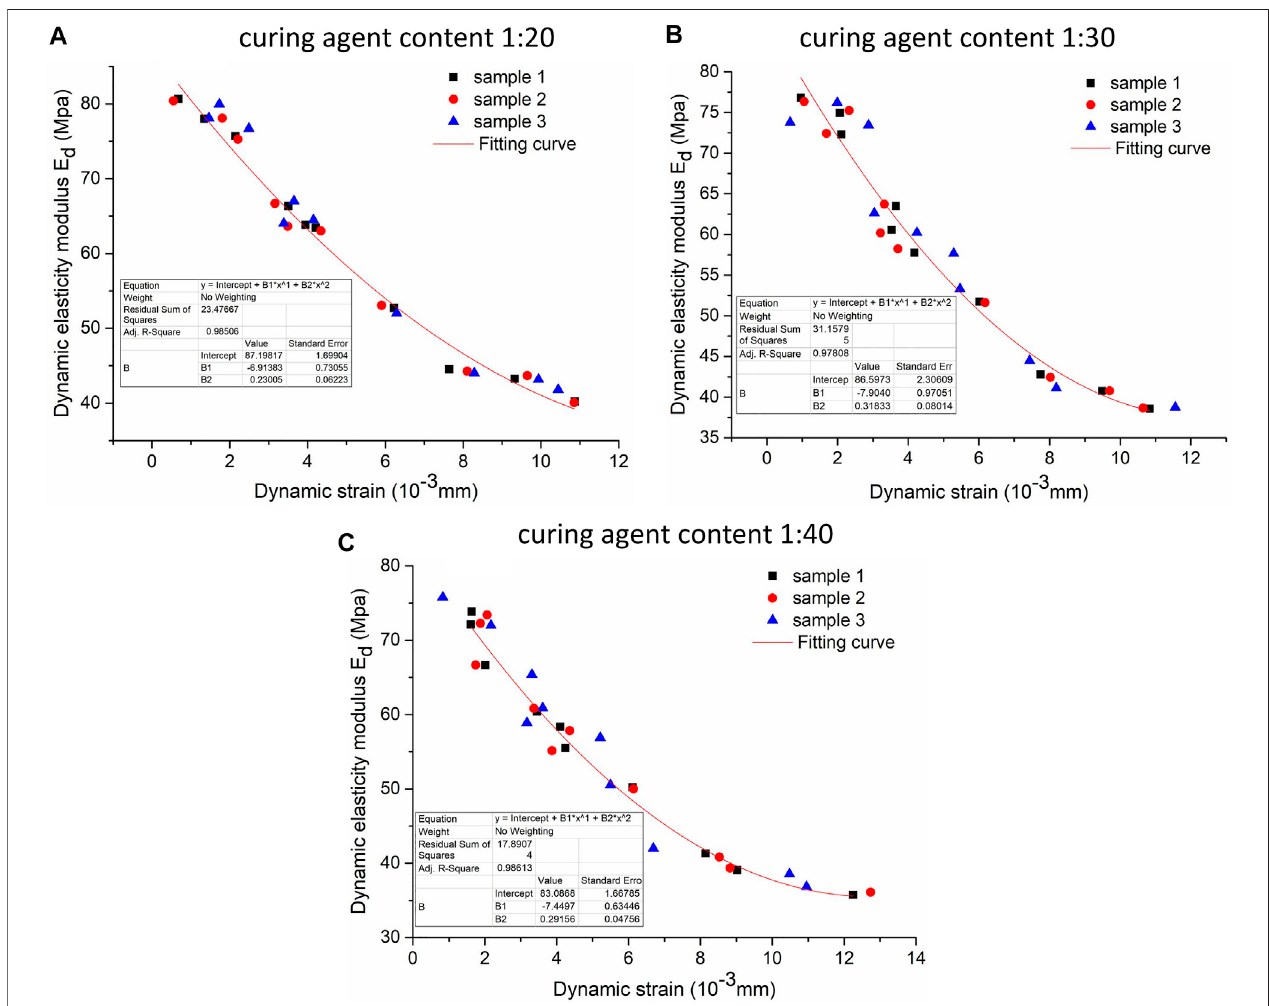
FIGURE 3 | Ed- ε d relation curve under dynamic load amplitude N (cid:1) 100N and different loading stages, Different curing agent content.